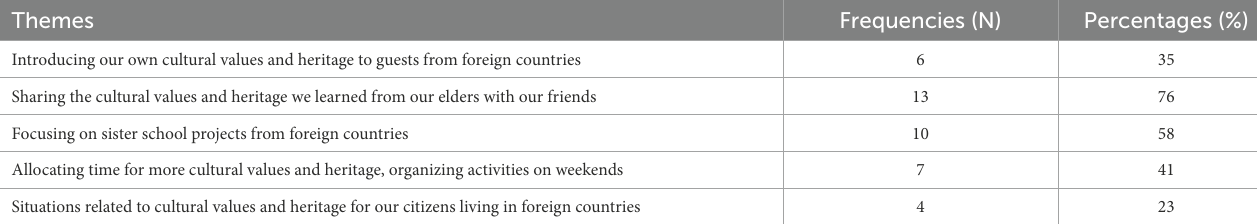
TABLE 2 Sharing of cultural values and heritage through storytelling in the digital